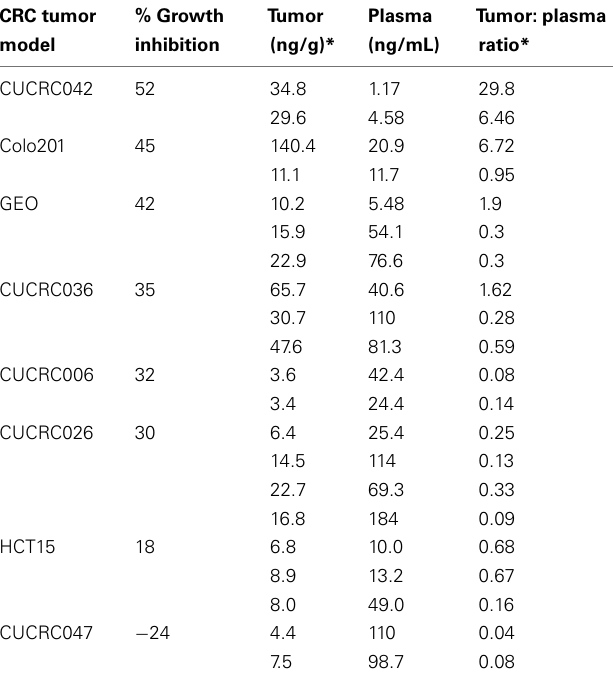
Table 3 | End of study tumor and plasma concentrations of